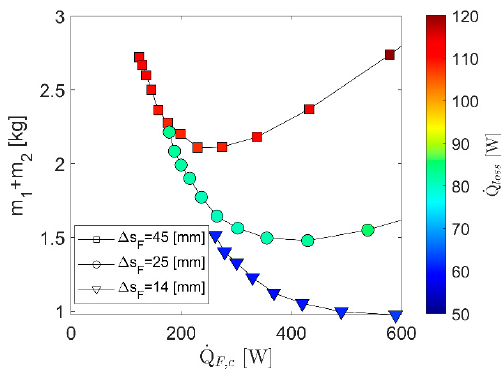
Figure 7. Total mass of the inner (m 1 ) and outer (m 2 ) thermal insulation as well as heat losses ( 𝑄(cid:4662) (cid:3039)(cid:3042)(cid:3046)(cid:3046) )